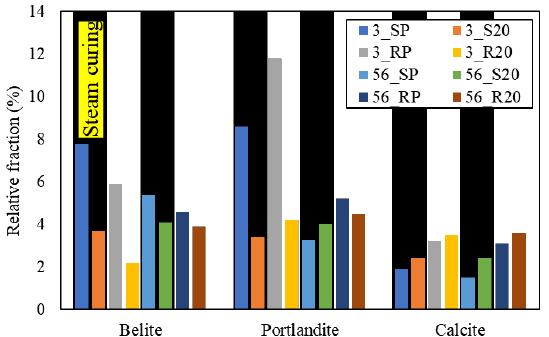
Figure 6. Quantitative calculation results for clinker constituents and product hydrates calculated from the results of XRD quantitative analysis.